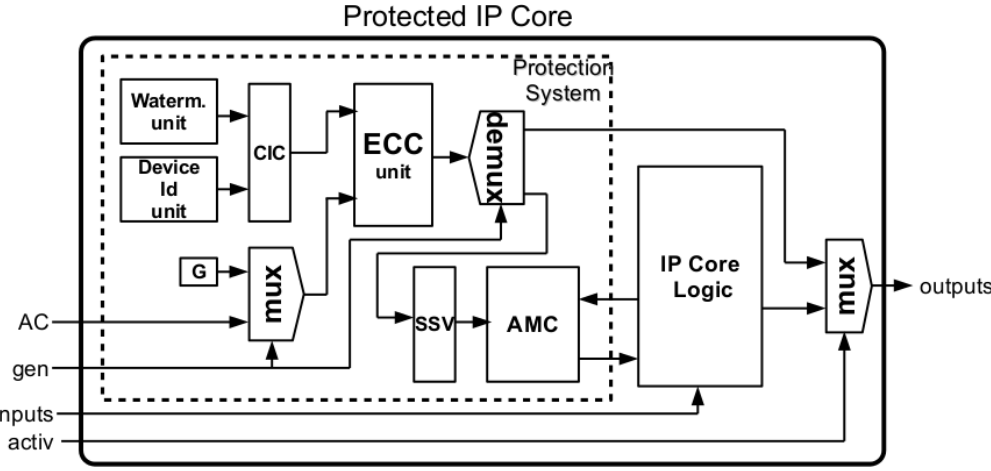
Figure 2. Block diagram of a SEHAS protected IP